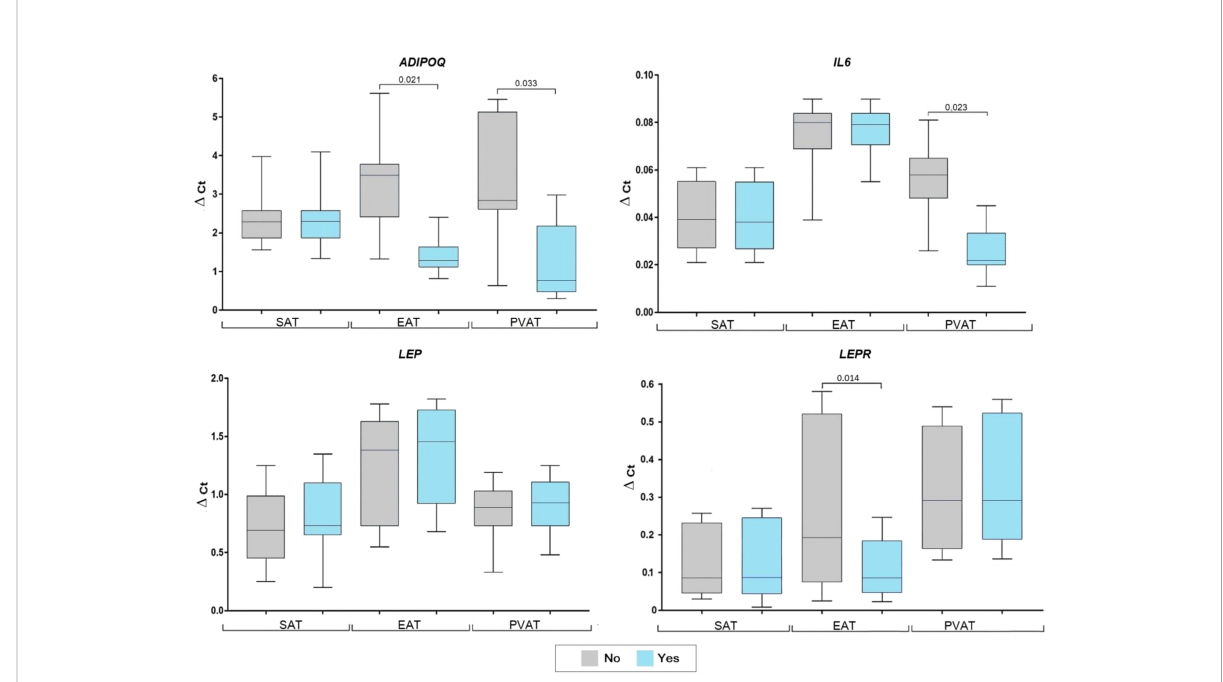
FIGURE 3 Adipocytokine gene expression in the adipocytes collected from adipose tissue based on the presence of dyslipidemia in coronary artery disease patients. Data are presented in Me (Q1; Q3). SAT, subcutaneous adipose tissue; EAT, epicardial adipose tissue; PVAT, perivascular adipose tissue; p, level of sta-tistical signi fi cance; sOB-R, soluble leptin receptor; IL6, interleukin